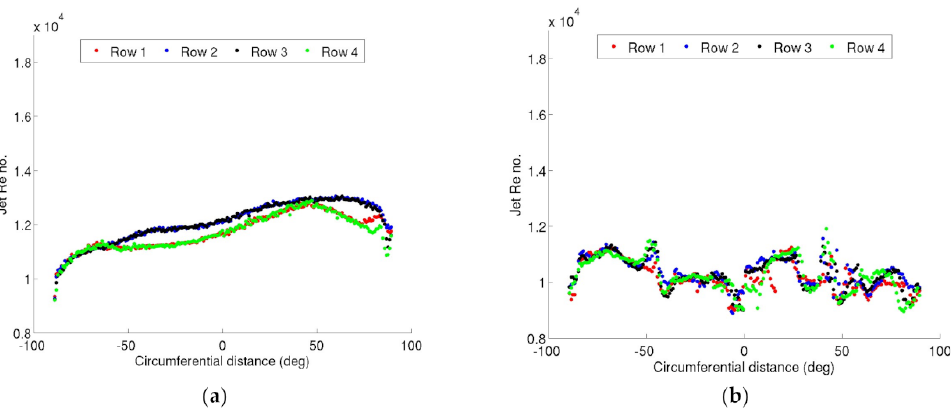
Figure 11. Jet Reynolds number within each hole in the ( a ) single–entry system and ( b ) multiple– entry system, in both cases defined with respect to the area-averaged jet velocity through the hole and the diameter of the